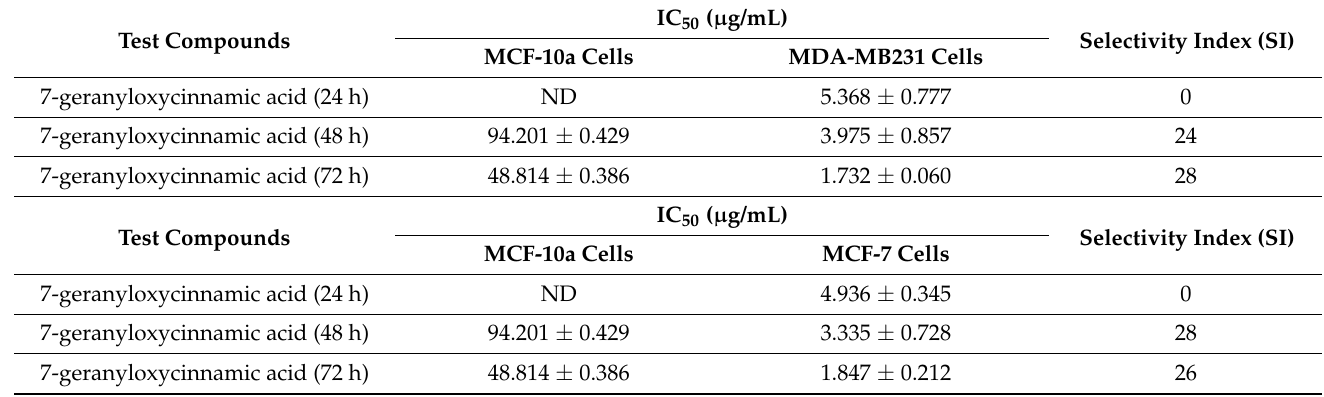
Table 5. Selectivity index (SI) of 7-geranyloxycinnamic acid and 5-fluorouracil on human breast cancer MDA-MB231, human colon cancer HT29, human breast cancer MCF-7, and human normal breast MCF-10a cells after 24, 48, and 72 h of